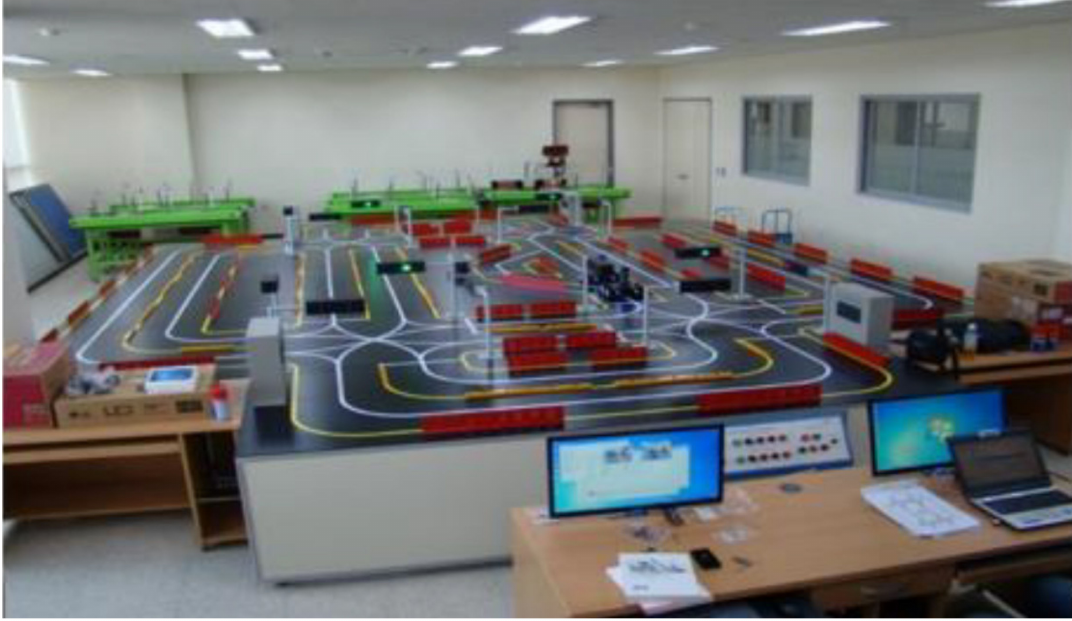
Figure 9. Test platform of a smart tra ffi c light